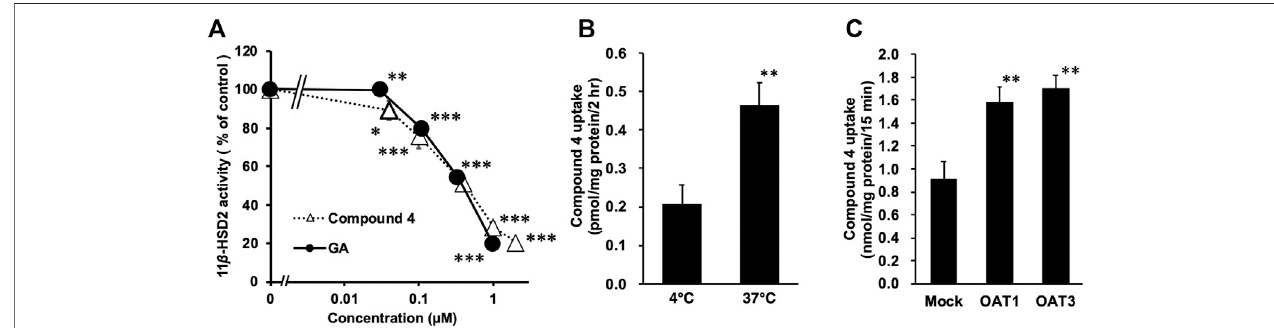
FIGURE2| Inhibitoryeffectsofcompound 4 ontype-211 β -hydroxysteroiddehydrogenase(11 β -HSD2)usingratkidneymicrosome(A),andtheuptakeof 4 intorat kidney slices (B) or into HEK293 cells transfected with organic anion transporter (OAT) 1 (C) or OAT3 (D). (A) [ 3 H] cortisone and glycyrrhetinic acid (GA) or 4 were mixed with rat kidney microsome fractions, and incubated at 37 ° C for 30 min. Then, the amount of [ 3 H] cortisol was measured. Data are means ± standard error (S.E: n (cid:2) 4) of percentage [ 3 H] cortisol in mixtures without samples.* p < 0.05, ** p < 0.01and *** p < 0.001comparedwithgroups without samplesusing Dunnett ’ smultiple t -test (B) Female Eisai hyperbilirubinuria rats (EHBRs) were orally treated with GA (200 mg/kg), and their plasma samples were collected 24 h after the treatment. Concentration of 4 in plasma sample was 115 µM. Kidneys were collected from normal Sprague-Dawley (SD) rats and slices were incubated with plasma samples of female EHBRs at 37 ° C or 4 ° C for 2 h, and then homogenized. Samples were those described in our previous study (Ishiuchi et al., 2019). Concentrations of 4 in kidney slice homogenates were measured using liquid chromatography-tandem mass spectrometry (LC-MS/MS). ** p < 0.01 vs 4 ° C group using Student ’ s t -test (C) Male EHBRs were orally treated with GA (200 mg/kg) and their plasma samples were collected 24 h after treatment. Concentrations of 4 in plasma sample was 189 μ M. HEK293cellstransfectedwithOAT1orOAT3wereincubatedwith1:2dilutedplasmasamplesofmaleEHBRsat37 ° Cfor15 min.Then,concentrationsof 4 incellswere measured using LC-MS/MS. Data are means ± S.E. ( n (cid:2) 6). * p < 0.05 vs mock cells using Dunnett ’ s multiple t -test.